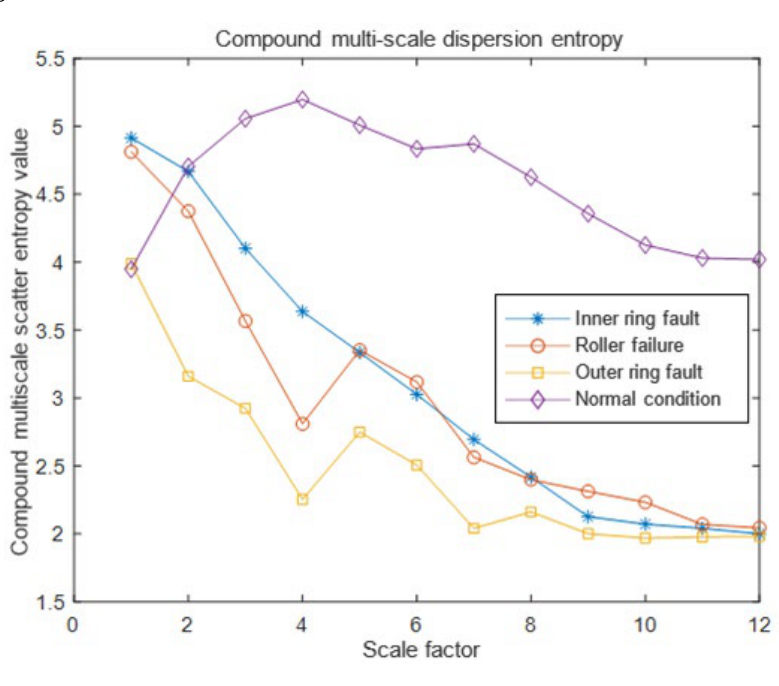
= 12. Figure 6. VMD-CMDE at τ = = 12. 𝜏𝜏 𝜏𝜏